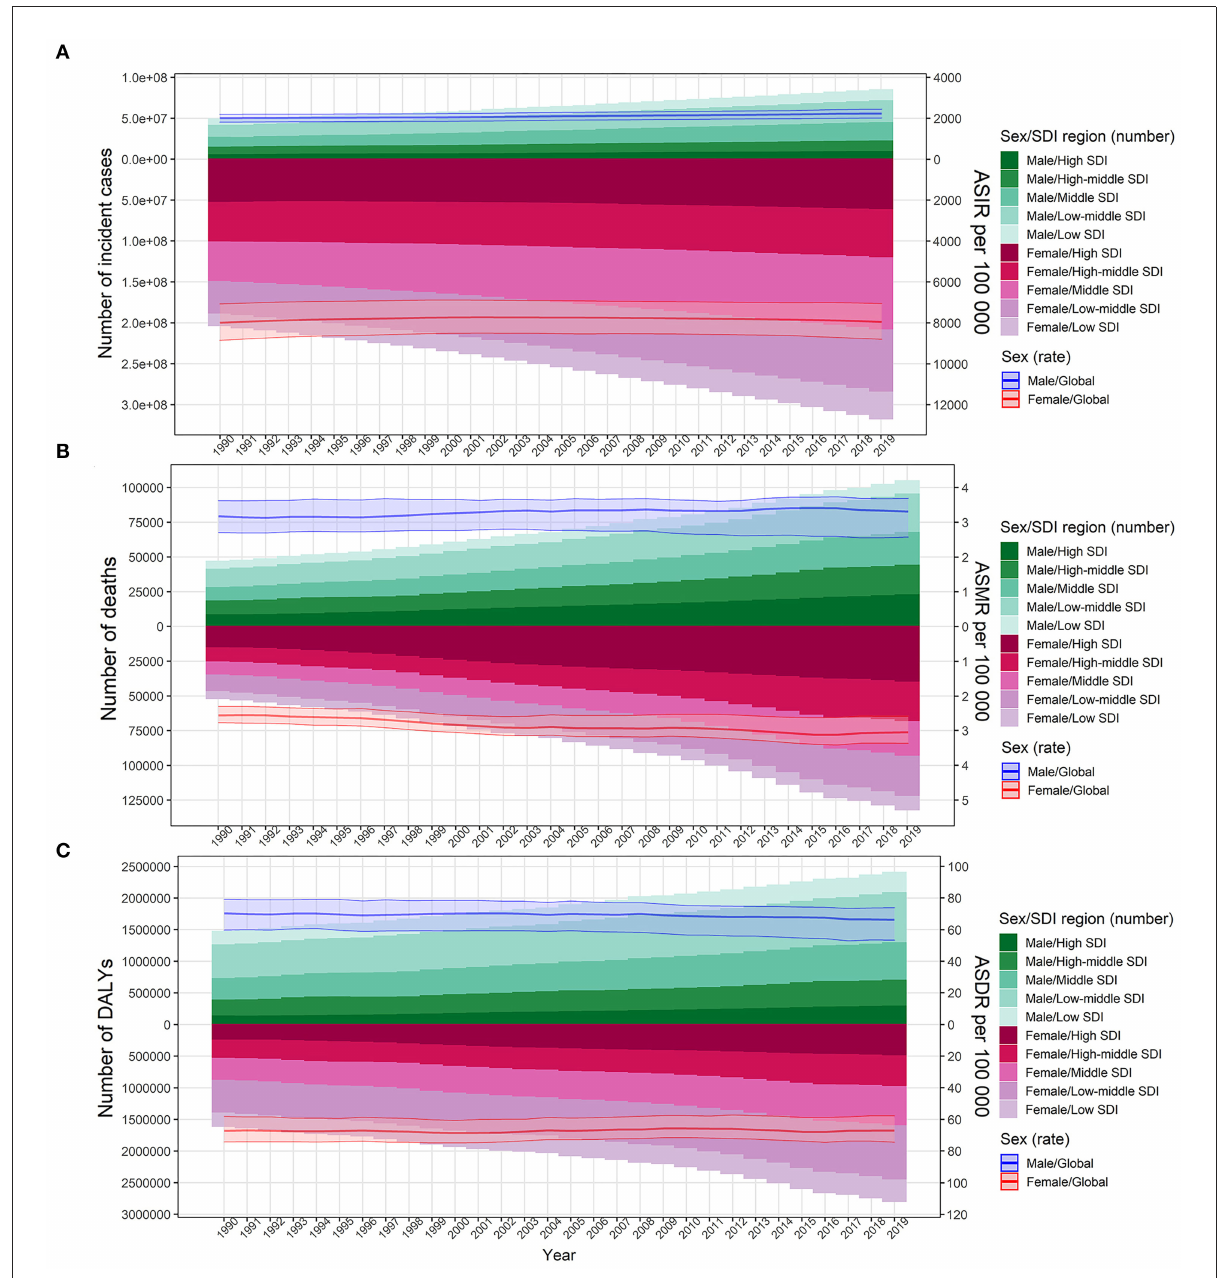
FIGURE1 Number of cases and age-standardized rates of urinary tract infection burden according to sex for the period 1990 to 2019. The bar plot presented the absolute burden of urinary tract infection, and the line plot presented the age-standardized burden rate of urinary tract infection. (A) Incidence of urinary tract infection. (B) Mortality associated with urinary tract infection. (C) DALYs associated with urinary tract infection. DALYs, disability-adjusted life years; SDI, socio-demographic index; ASIR, age-standardized incidence rate; ASMR, age-standardized mortality rate; ASDR, age-standardized DALY